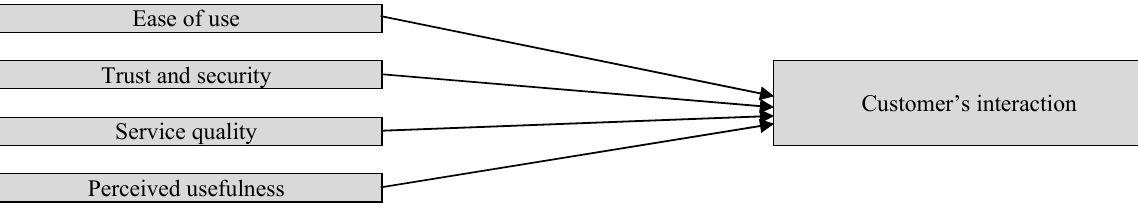
Fig. 1. Description of the study